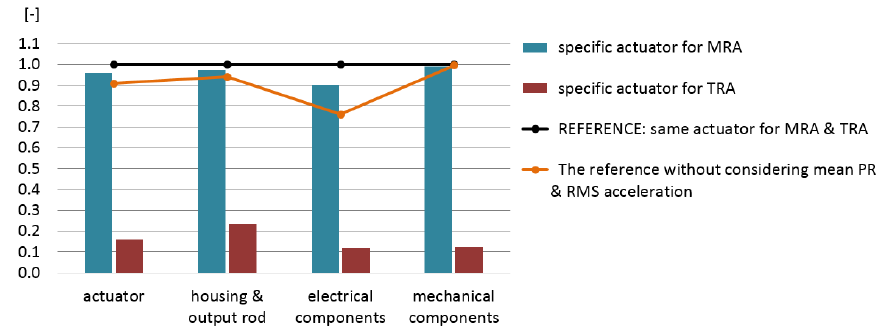
Figure 25. Mass distribution of specific actuators for the MRA and TRA applications compared to a unique actuator for both